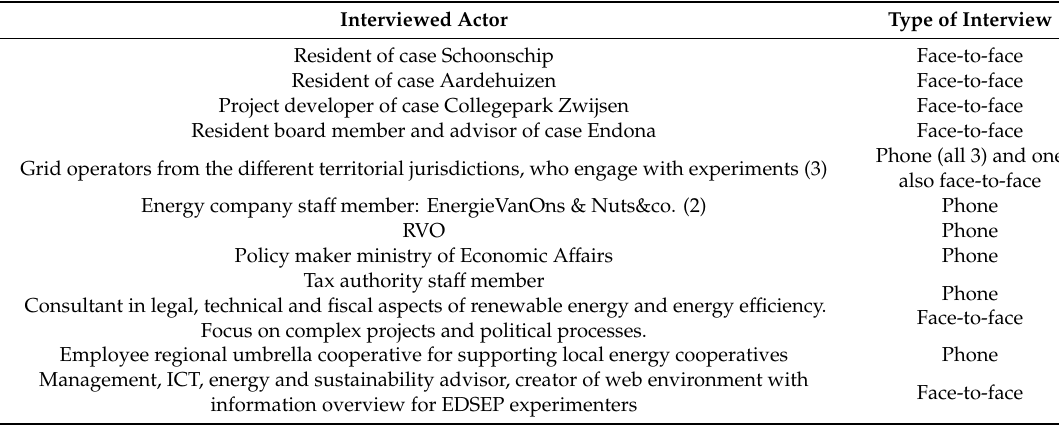
Table A2. Overview of interviewed